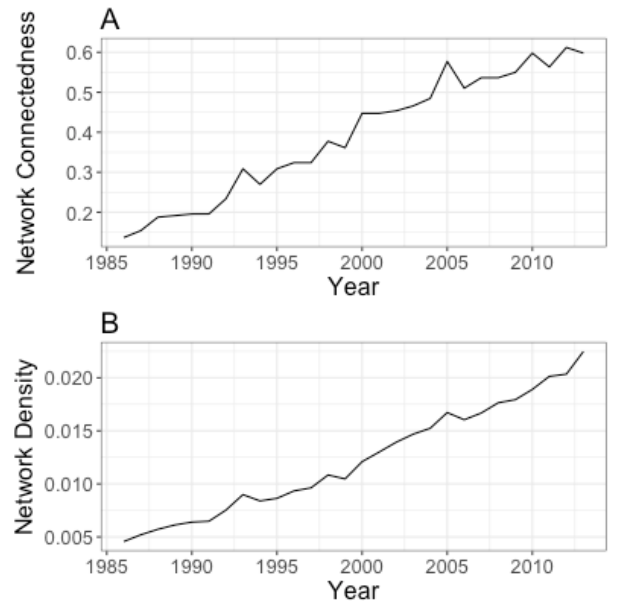
Fig. 4 . Change in the connectivity of the soybean metacoupled system during 1986–2013: (A) network connectedness, or the fraction of all pairs of nodes where an undirected path exists, where 0 indicates an unconnected network and 1 indicates a completely connected network, (B) network density, or the portion of possible connections in a network that are actual connections.